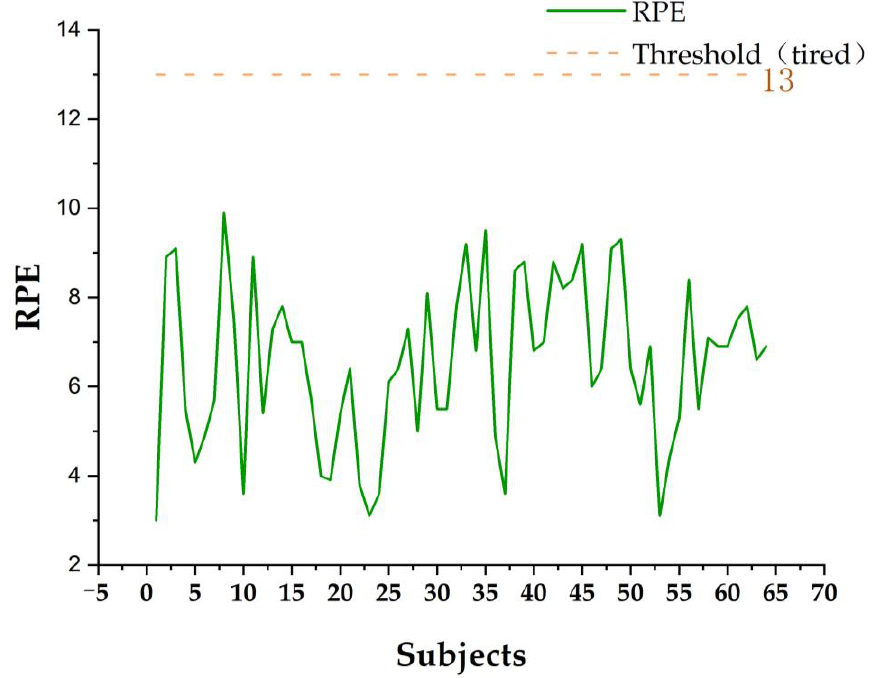
Figure 12. Numerical trend of RPE. Source: Origin 2021 software production. RPE 13 is the threshold, RPE ≥ 13 is the fatigue state.